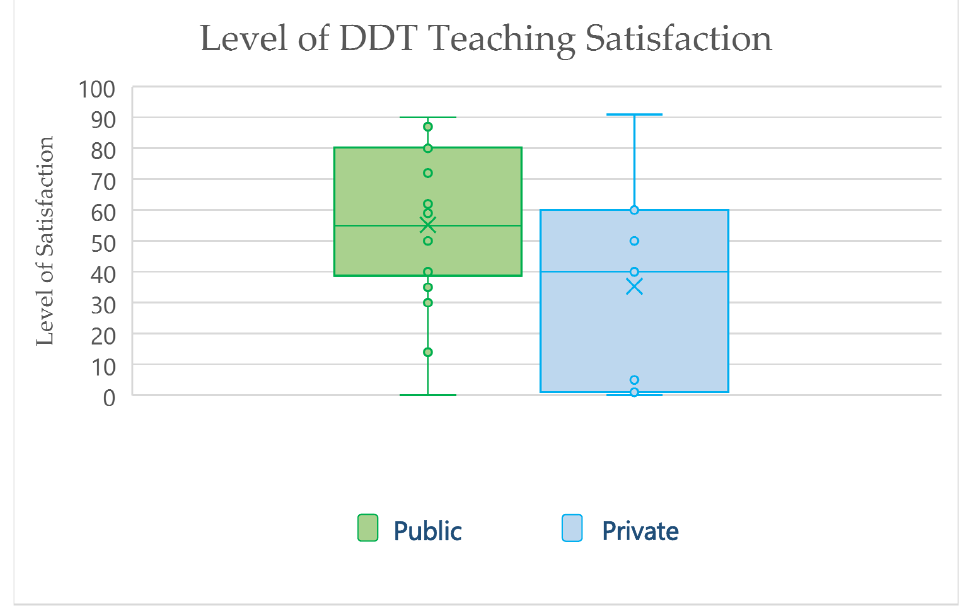
Figure 1. Responses of Saudi Arabia dental schools reporting their level of satisfaction in teaching digital dental technologies in their curricula (18 public; 7 private). One of the included private schools failed to complete the satisfaction level. DDT, digital dental technology.